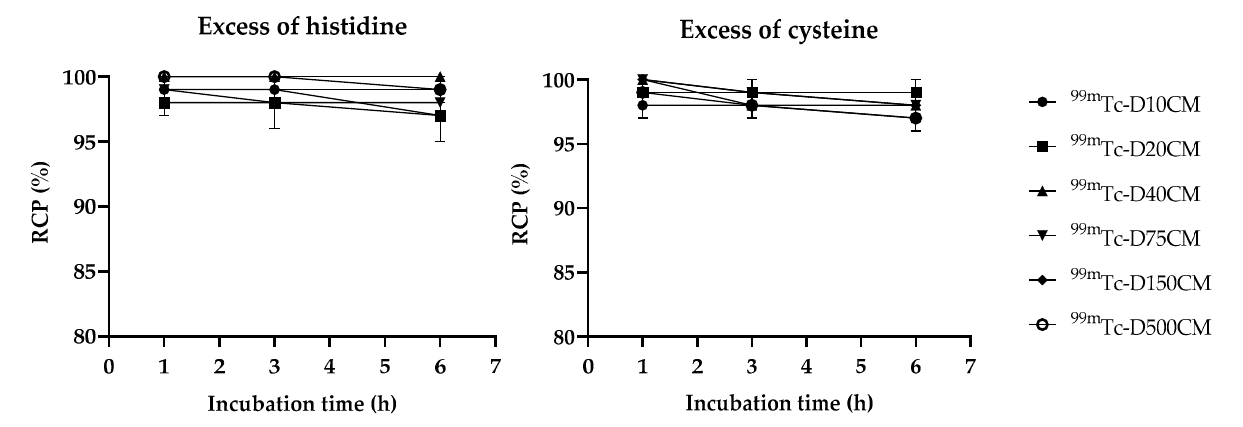
Figure 2. In vitro stability of 99m Tc − D10CM– 99m Tc − D500CM in the presence of excess histidine and cysteine (10 − 2 M) at 37 °C for 1, 3, and 6 h.